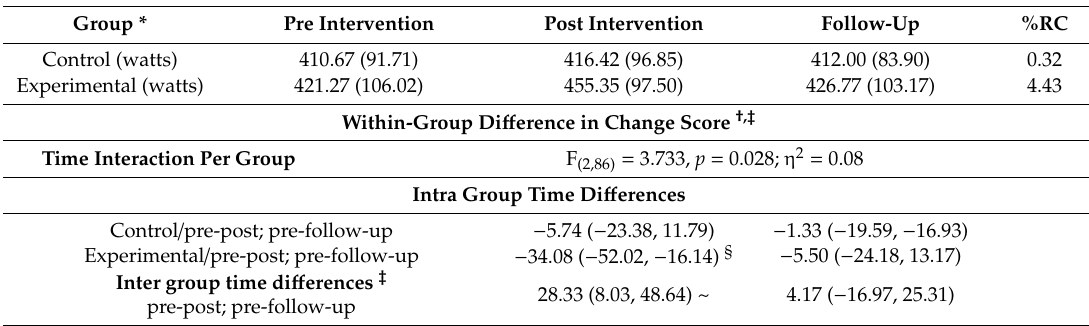
Table 5. Power intra- and inter-group di ff